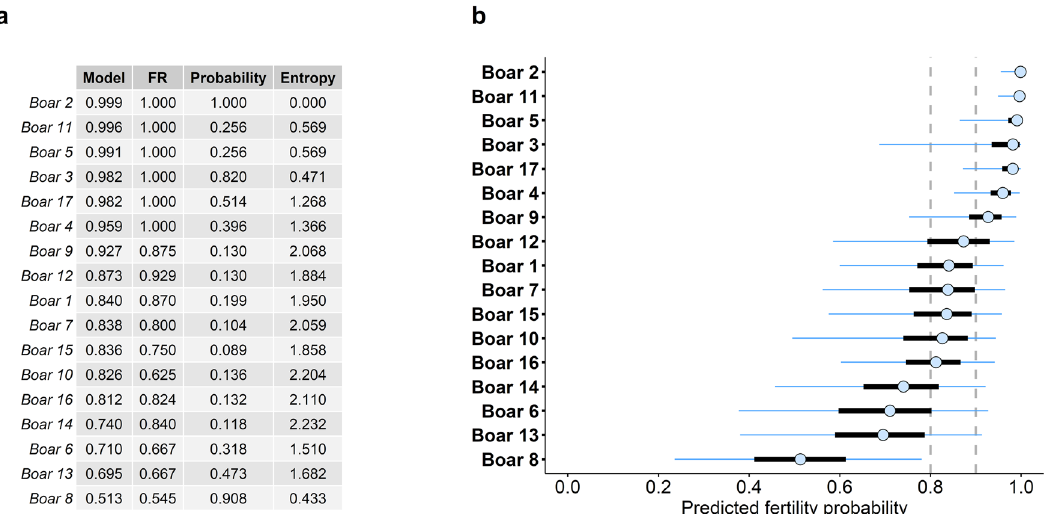
Fig. 4 Predicted fertility per boar. The values represent the median predicted fertility, expressed as probability of success (successful oocyte fertilisation). a Table of comparison between the estimated (posterior median) fertility, and the farrowing rate (FR), a commonly used measure of fertility. The boars are ranked in descending order according to the predictions of the model. The pseudo-probability (in a 1000 iteration bootstrap) is presented for each boar to p ð p Þ , where p is the probability of belonging to i th position) is used as a be ranked in the current position. Additionally, entropy (calculated as (cid:1) ∑ 17 i ¼ i ln i 1 measure of position diversity for each of the boars. Namely, a higher entropy corresponds to boars that can be found in a broader range of positions, whereas a lower entropy corresponds to more robust boars. The Kendall's correlation between the predicted rank and the FR rank was calculated at each bootstrap iteration, yielding a mean correlation of 0.826 ± 0.055 (ranging from 0.662 to 1.000), with a mean p value of 1.7 × 10 − 6 ± 6.2 × 10 − 6 (ranging from 5.5 × 10 − 15 to 8.2 × 10 − 5 ). b Predictions with their corresponding uncertainty around the median (open dot). 50% credible intervals (C.I.) are represented by thick, black lines, while 95% C.I. are represented with blue thin lines. Boars are sorted in descending order, according to their estimated fertility (median). The vertical dotted lines represent thresholds at 0.8 and 0.9, corresponding with the categorisation of boars (relatively low or high fertility,